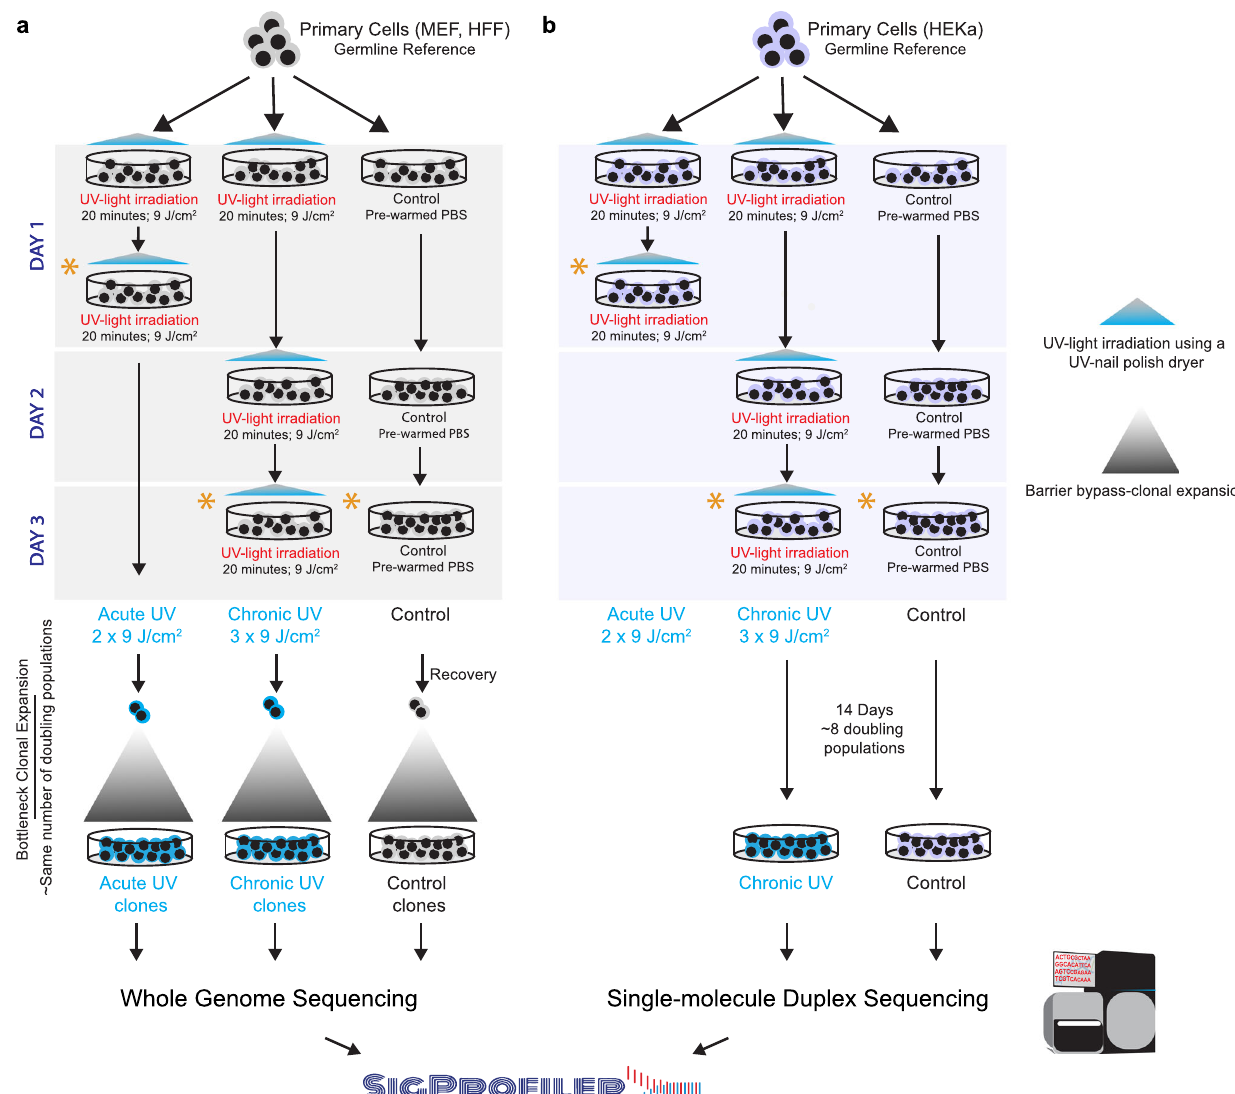
Fig. 1 | Overview of the overall study design. a Primary mammalian cells, MEFs and HFFs, were expanded into 6-well plates and treated with ultraviolet light (UV) emitted from a UV-nail polish dryer for 20min, twice a day within one single day, termed acute UV exposure . For chronic UV exposure , primary cells were exposed consecutively in three different days with each exposure lasting 20min. Control samplesweremaintainedinthedarkinpre-warmedPBSfor20minutesduringeach exposure session. After recovery and cellular selection, whether through senes- cence bypass or single-cell subcloning, control and irradiated cell were grown for the same number of doubling populations and subjected to bulk whole-genome sequencing. Analysis of whole-genome sequenced samples was performed using our established pipelines for mutation calling. Analysis of mutational signatures was performed using the SigPro fi ler suite of tools. b Primary HEKa cells were